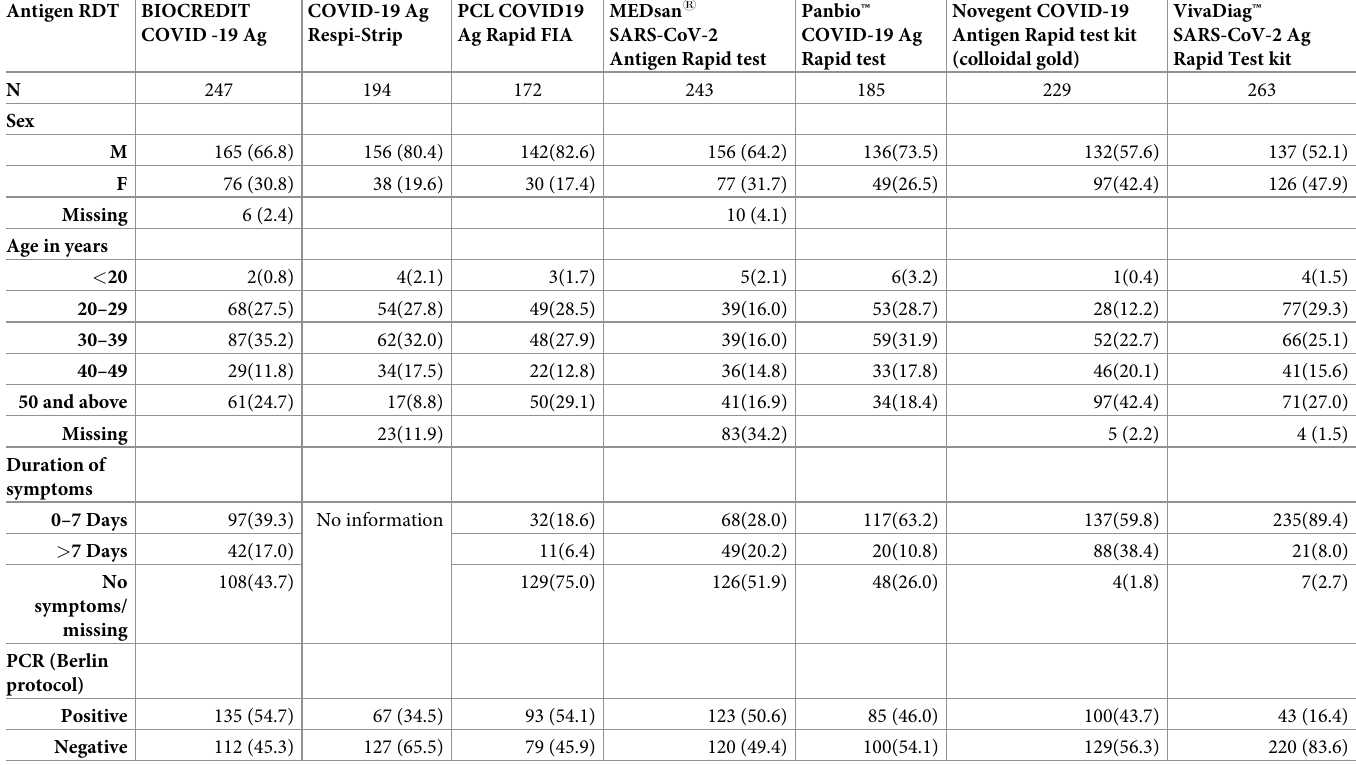
Table 1. Demographic characteristics of